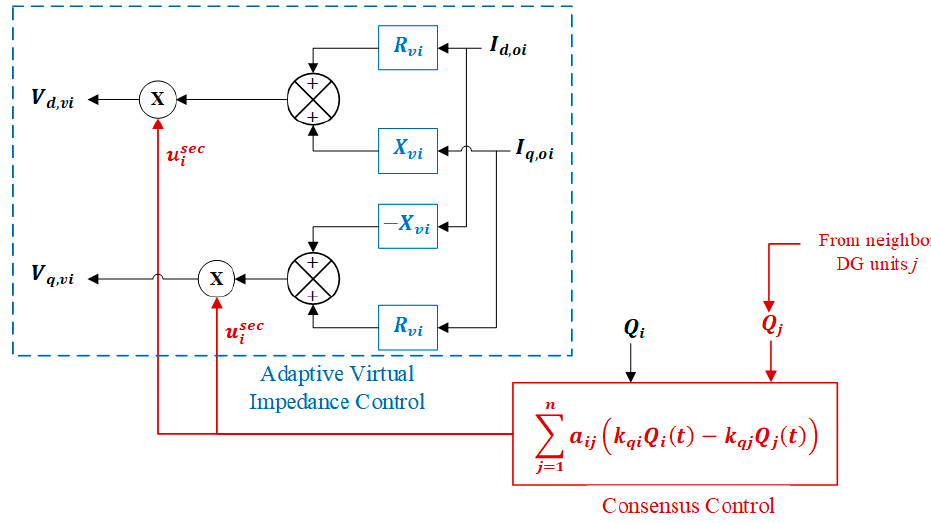
Figure 7. A scheme of adaptive virtual impedance control.